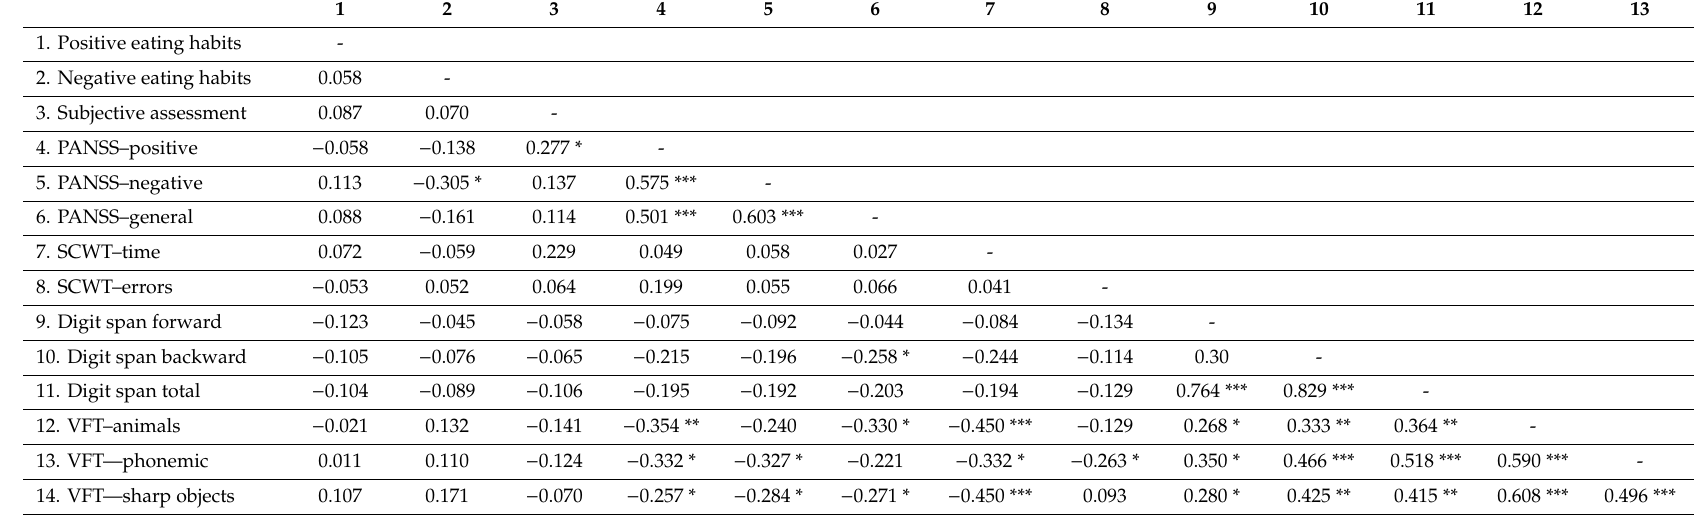
Table 4. Variable correlations in schizophrenia patients with MS ( N =